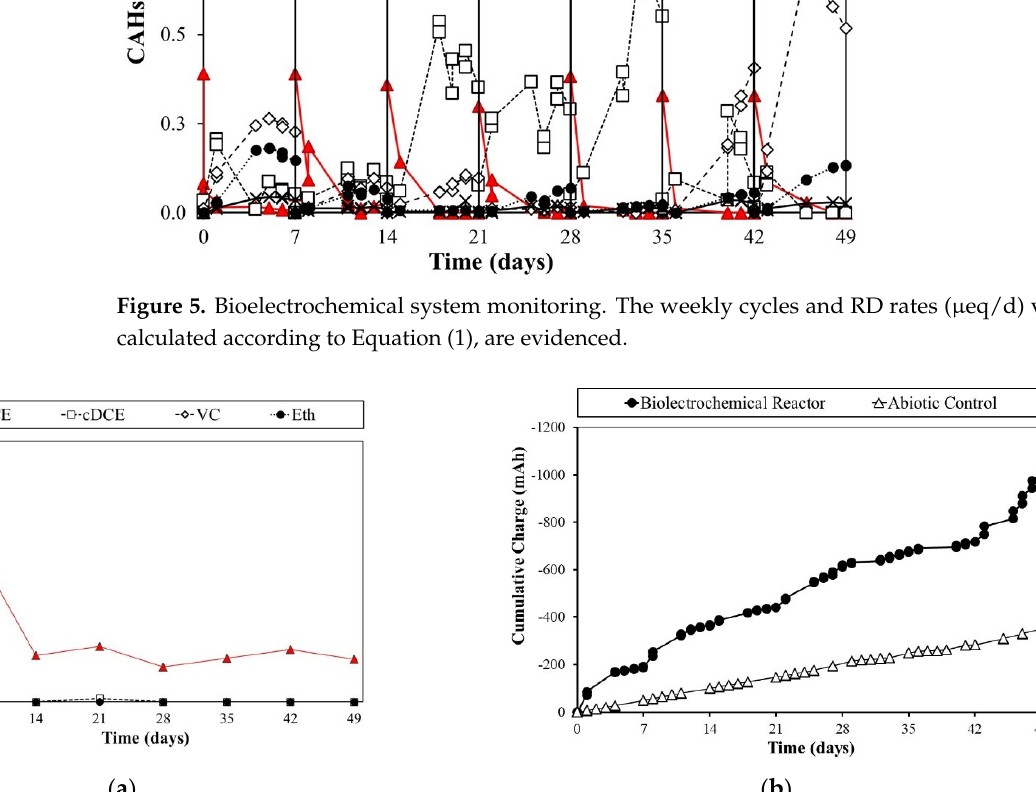
Figure 6. The CAHs monitoring in the abiotic H-cell system (cathode) ( a ) and the cumulative current (mAh) of the two electrochemical systems in comparison ( b ).